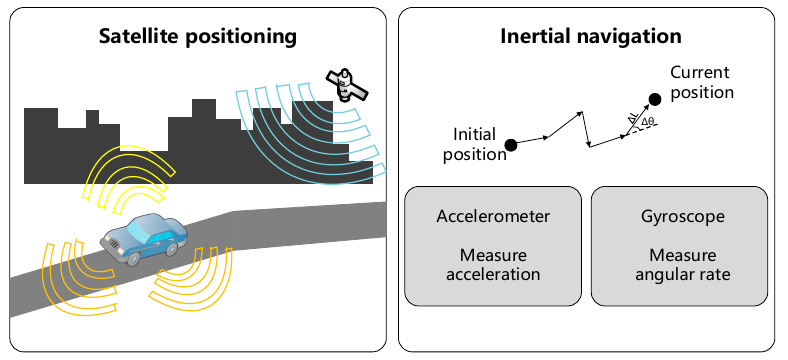
Figure 2. The work principle of the INS in vehicular scenarios.